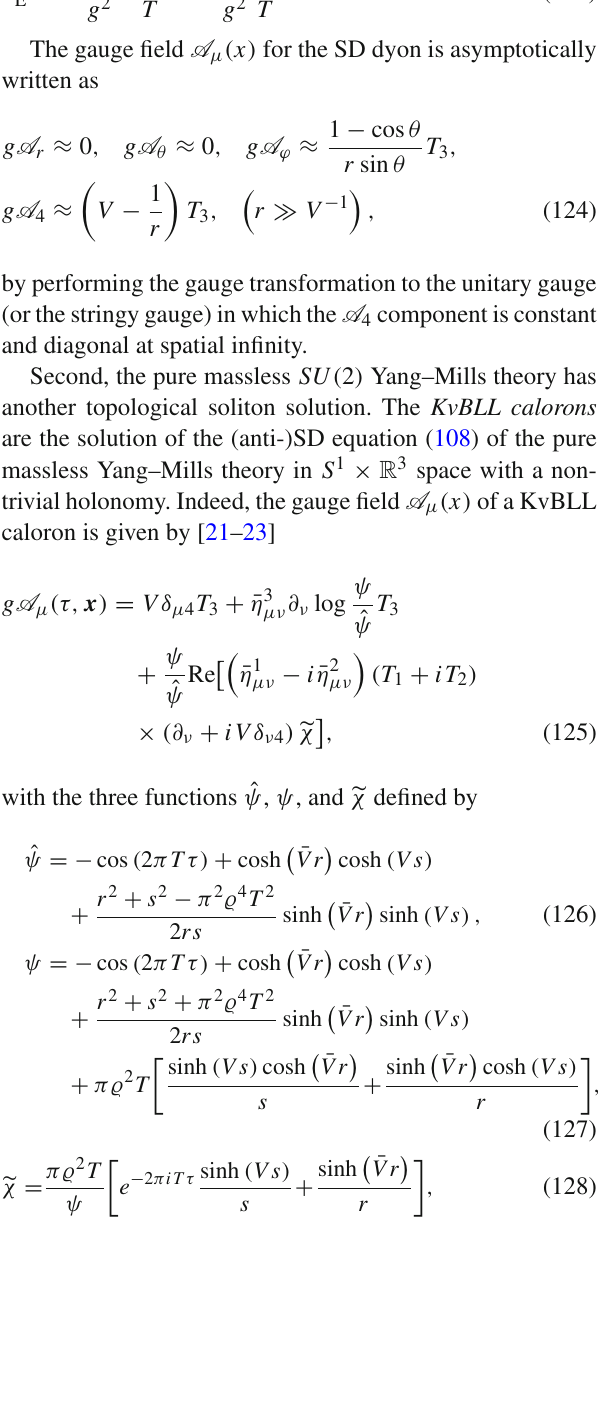
where ¯ η A μν is the ’t Hooft symbol defined by ¯ η A μν = (cid:2) A μν